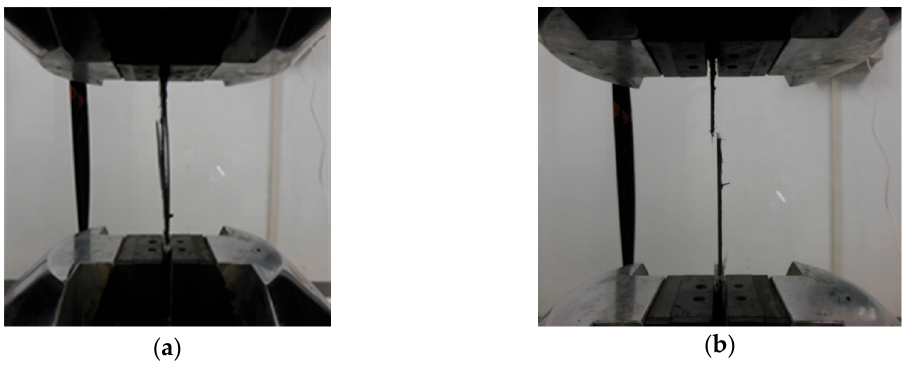
Figure 11. Failure modes of the CFRP after EC test for 310 days: ( a ) Delamination failure; ( b ) Rupture failure.